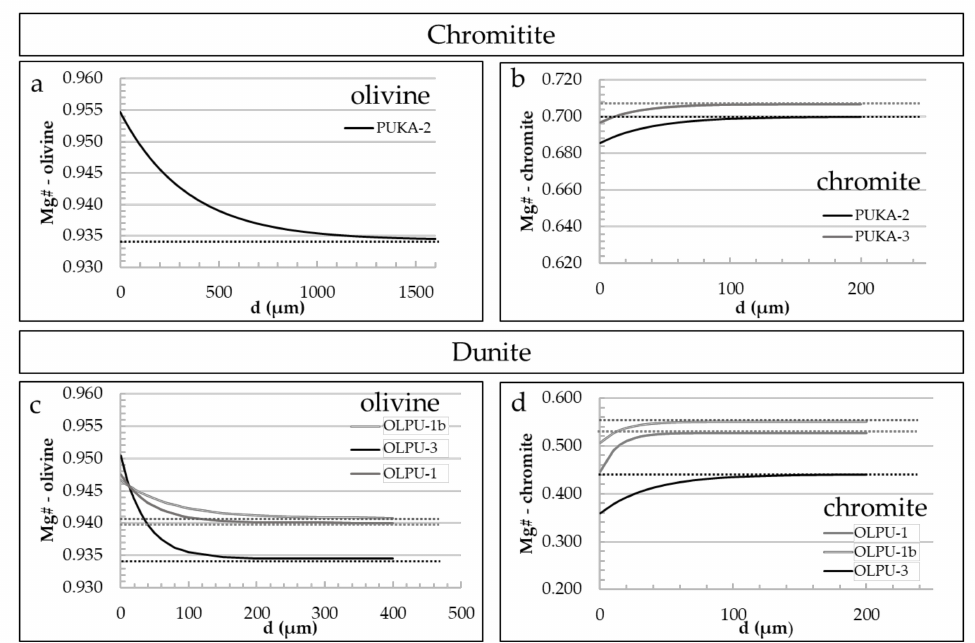
Figure 10. Diffusivity curves determined for olivine and chromite in dunites and chromitites of Iballe; the curves were computed through OriginPro software. ( a ) diffusivity curves of olivine in chromitites, ( b ) diffusivity curves of chromite in chromitites, ( c ) diffusivity curves of olivine in dunites, ( d ) diffusivity curves of chromite in